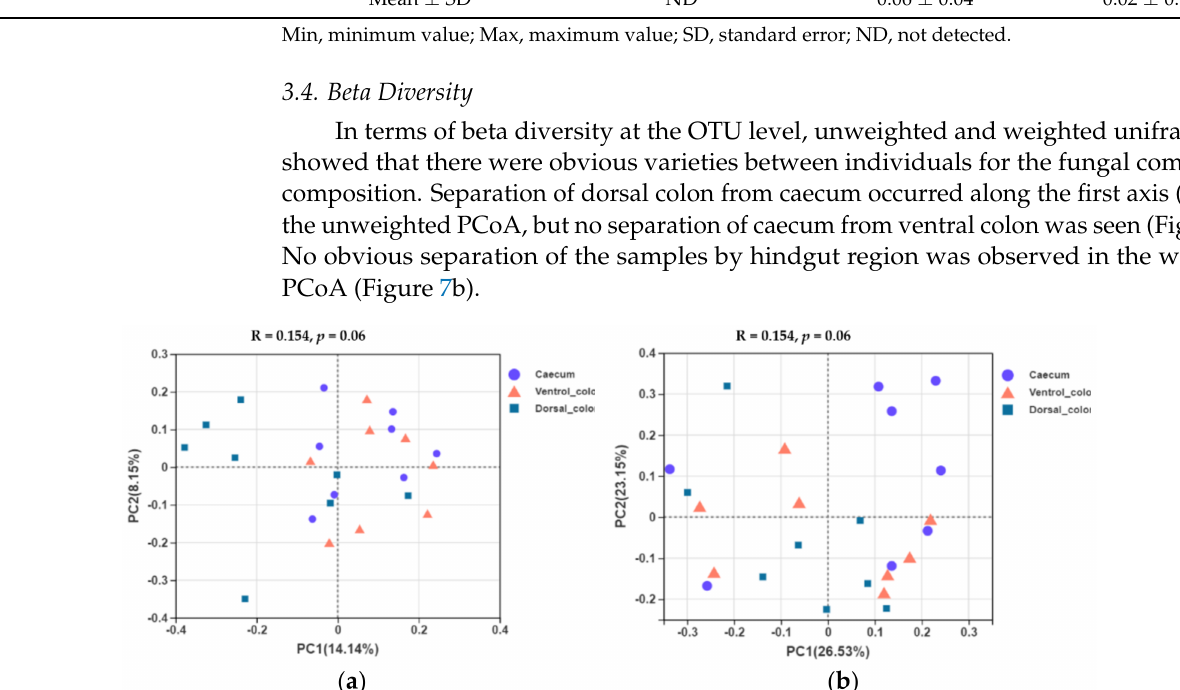
Figure 7. Unweighted ( a ) and weighted ( b ) unifrac based principal coordinates analysis (PCoA) of the fungal community composition of the different hindgut regions at the OTU level. Analysis used Log 10 transformed data, and the percentage values given on each axis indicate the amount of total variation represented. PC1, first axis; PC2, second